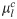
Overall mortality rates of aquatic forms μlc (a) and μpc (b) during the period of time (October) 1995–2012 (September).